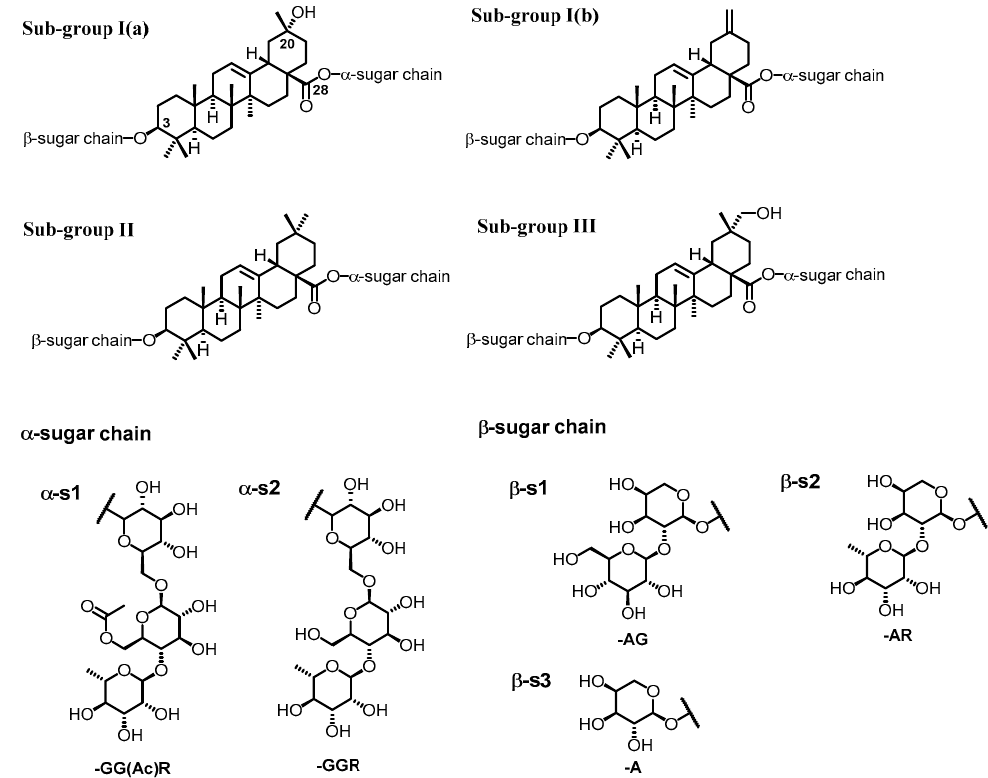
Figure 2. Aglycones of three sub-groups of triterpene glycosides in E. senticosus.